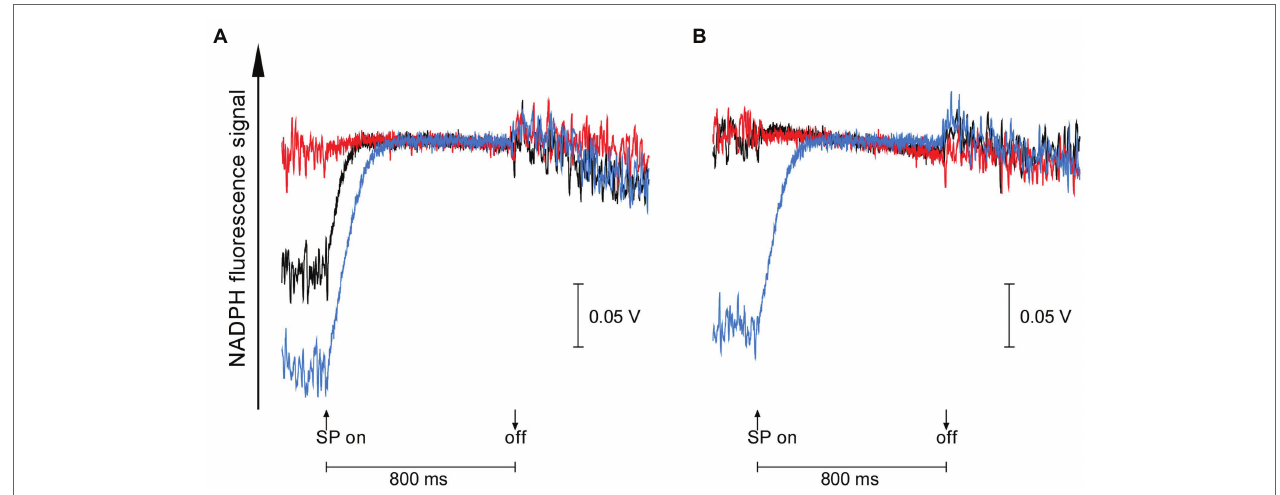
FIGURE 2 | The dark-to-light induction kinetics of NADPH fluorescence upon saturating pulse (SP) of 800 ms in the absence (A) or presence (B) of glucose. Black line, the wild-type strain; red line, Δ ndhF1 ; and blue line, Δ gnd . Prior to measurements, cells were dark-acclimated for 15 min. The average of kinetics of three independent cultures in each strain is presented.